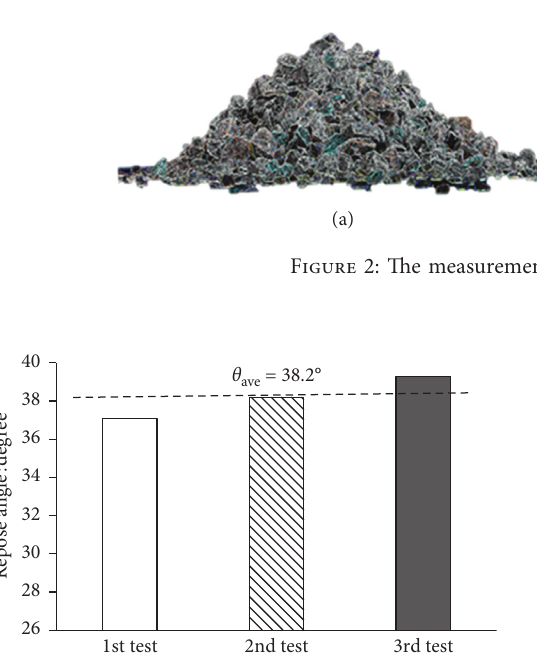
Figure 3: Experimental result of the repose angles from repeated :average angle of repose. tests. Note: θ ave